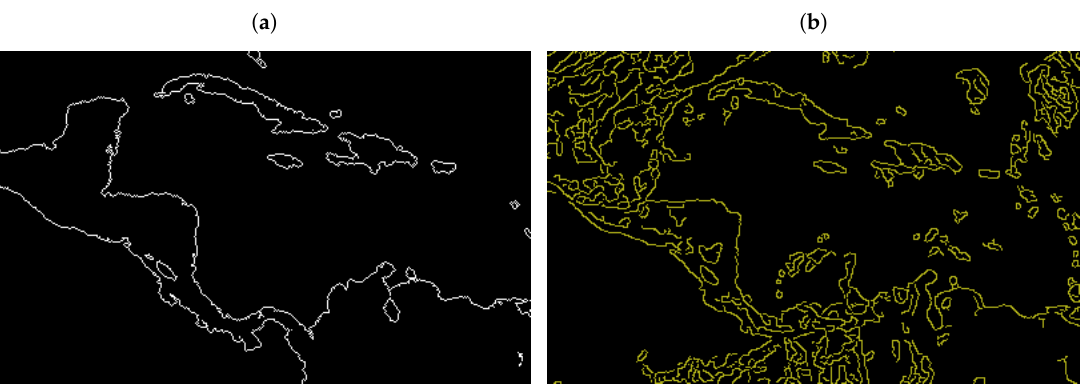
Figure 3. Comparison of the ( a ) theoretical and ( b ) radiometric coastlines for one of the regions shown in Figure 1. The radiometric coastline is partially polluted with other type of borders detected by the Canny algorithm (e.g., clouds or interfaces between two different land